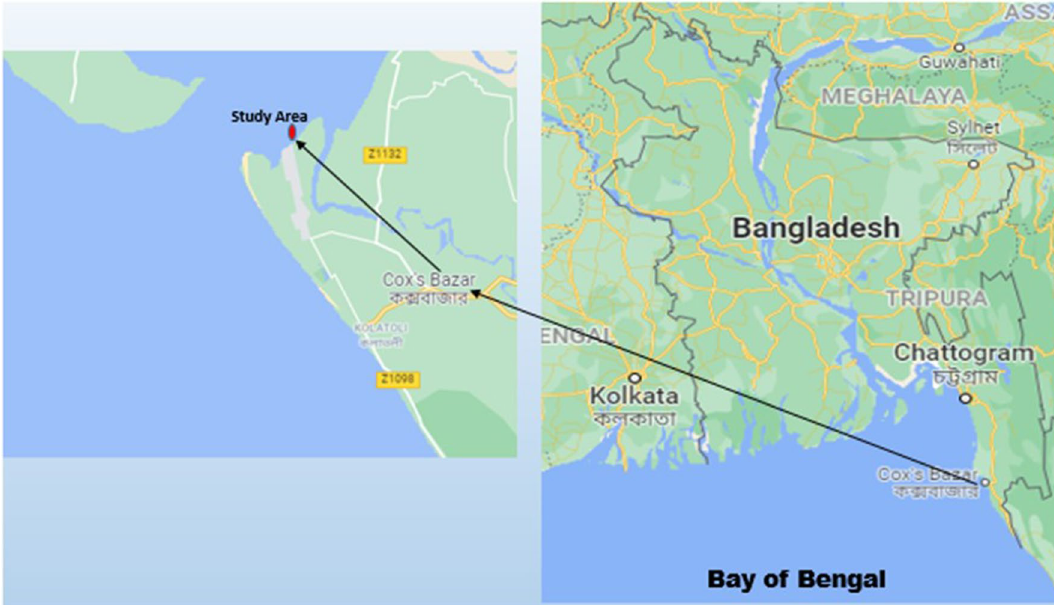
Figure 3. Google. (n.d.). [Location of the study area at Nuniarchara, Cox’s Bazar]. Retrieved November 15, 2021, from https:// goo. gl/ maps/ pfx8r tfQR2 ZxZ8G